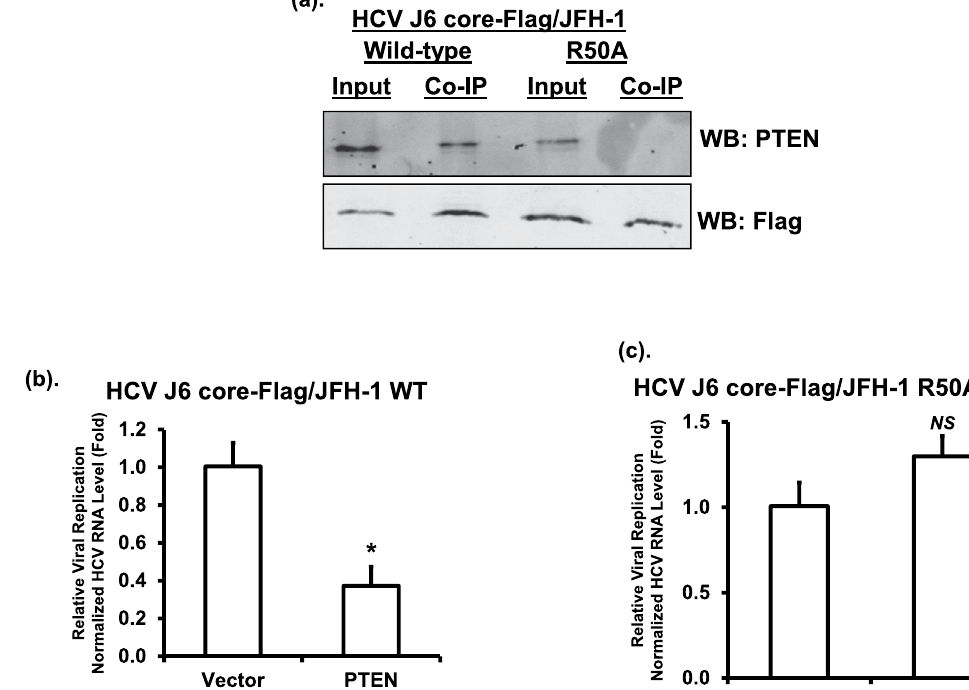
Figure 7. PTEN-HCV core interaction in HCV replicating cells and inhibits HCV replication. ( a ) The lysates prepared from Huh-7 cells harboring HCV-2a J6 core-Flag/JFH-1(p7-rLuc-2A) or HCV-2a J6 core R50A-Flag/ JFH-1(p7-rLuc-2A) replicating RNAs were subjected to immunoprecipitation (IP) using an anti-Flag antibody. Input and IP products were analyzed by Western blotting (WB) using anti-PTEN and anti-HCV core antibodies, respectively. This experiment was performed twice. ( b and c ) Huh-7 cells harboring HCV-2a J6 core-Flag/JFH- 1(p7-rLuc-2A) ( b ) or HCV-2a J6 core R50A-Flag/JFH-1(p7-rLuc-2A) ( c ) replicating RNAs were transfected with vector or PTEN-expressing plasmid. At 48 hours after transfection, HCV RNA level was determined by reverse transcription real-time PCR using HCV-2a-specific primers. The transcript level of β -glucuronidase (GUSB) was used for normalization. The statistical differences between samples were demonstrated as * if p ≤ 0.05, ** if p ≤ 0.01, or NS for not significant. This experiment was performed